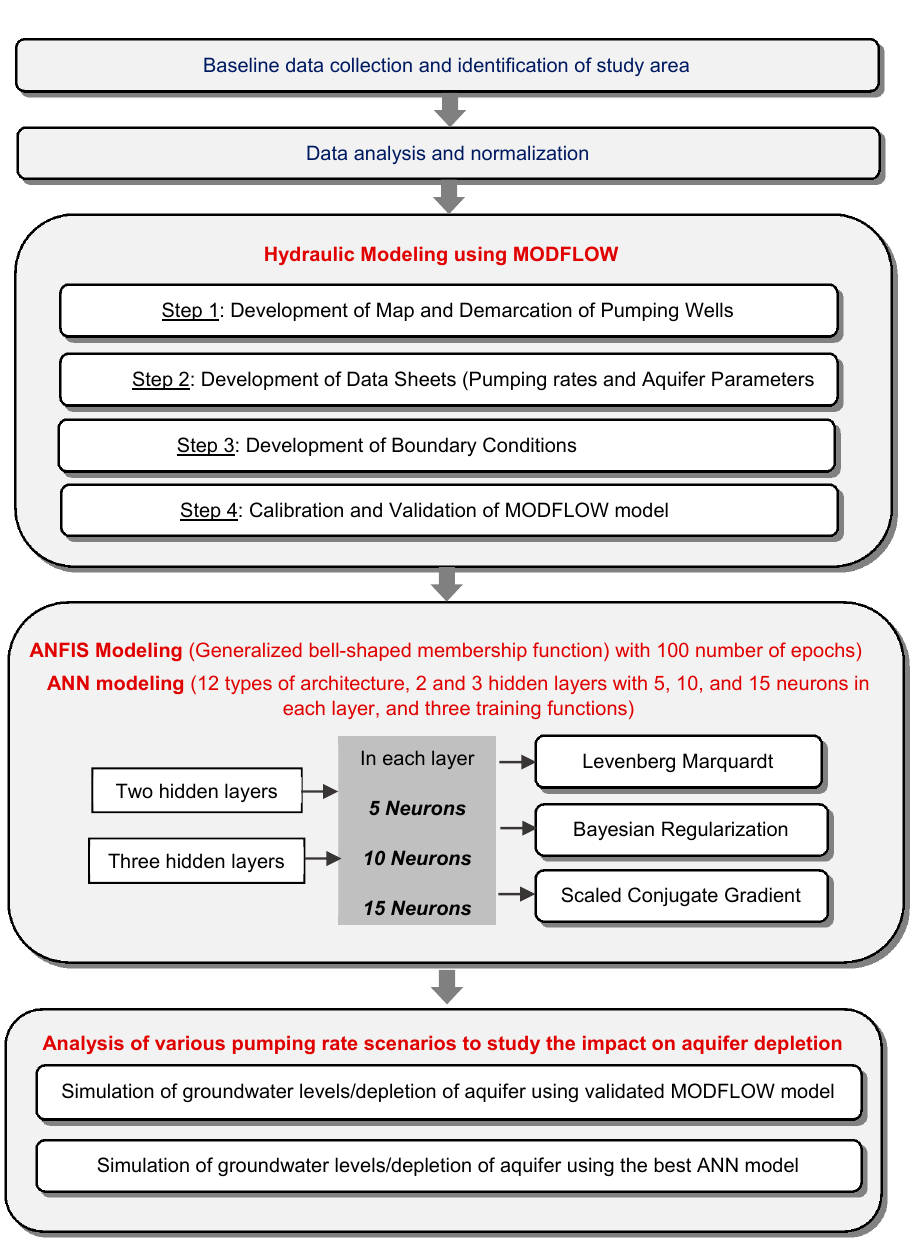
Figure 2. Groundwater Modeling Framework to Explore the Impacts of Pumping on Depletion of Aquifer.